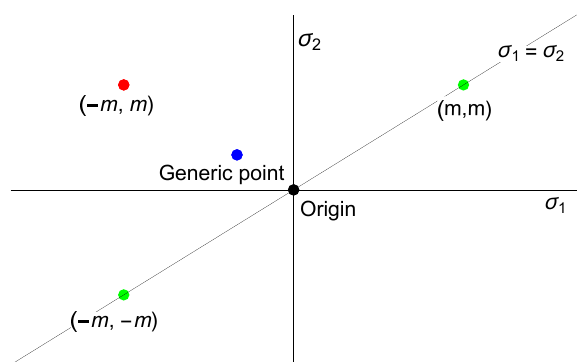
Figure 1 . This (cid:12)gure schematically shows the real parts of the two classical Coulomb branch parameters of U(2) N = 4 SQCD with N f pairs of hypermultiplets with real mass (cid:6) m . 2